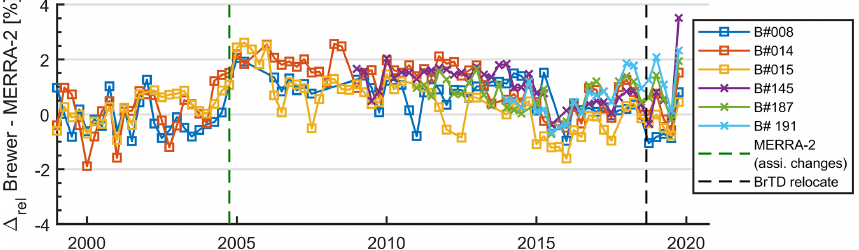
Figure 8. The relative difference between the reference Brewers and MERRA-2 reanalysis. Each point represents a 3-month average. The green dash line represents the time when MERRA-2 changed its assimilation sources from SBUV-2 to MLS/OMI (causing about 2% relative difference). The black dash line represents the time when BrT-D was relocated to